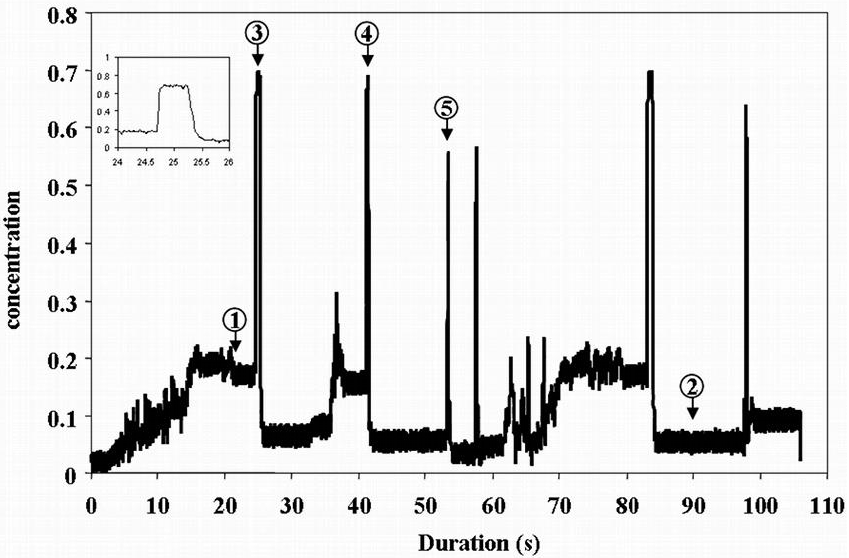
Figure 4. Evolution of the average concentration as a function of time recorded by the dual-plane ECT system. Case of plane 1. Arrows and numbers correspond to the special frame that is also analyzed using the rotatable sensor. 1 and 2 correspond to settled layers while 3–5 to slugs. The concentration profile of slug #3 is also magnified.